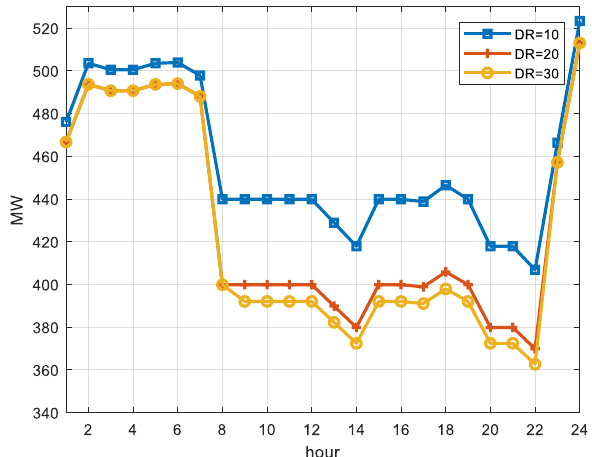
Figure 4. Day-ahead spinning reserve allocation under different system configurations.